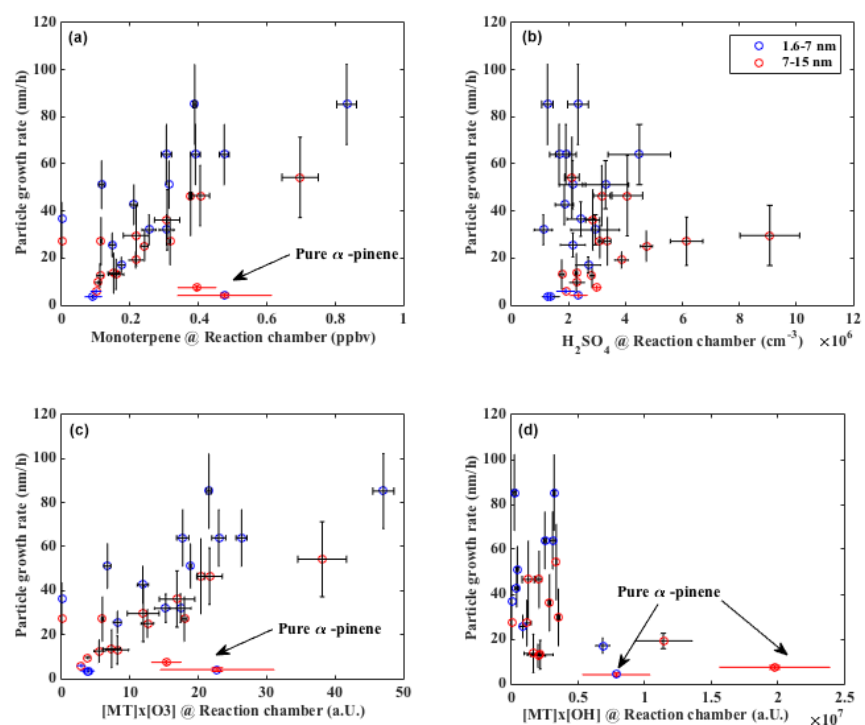
Figure 6. Particle growth rates (GR) at the beginning of the particle formation burst as function of (a) monoterpene concentrations in the JPAC reaction chamber and (b) H 2 SO 4 concentrations in the JPAC reaction chamber. (c) Proxy concentrations of oxidation products of monoterpenes by O 3 in the JPAC reaction chamber; (d) proxy concentrations of oxidation products of monoterpenes by OH in the JPAC reaction chamber. Red squares are growth rates of particles ranging from 1.6 to 7nm, and blues markers indicates growth rates of particles with a diameter of